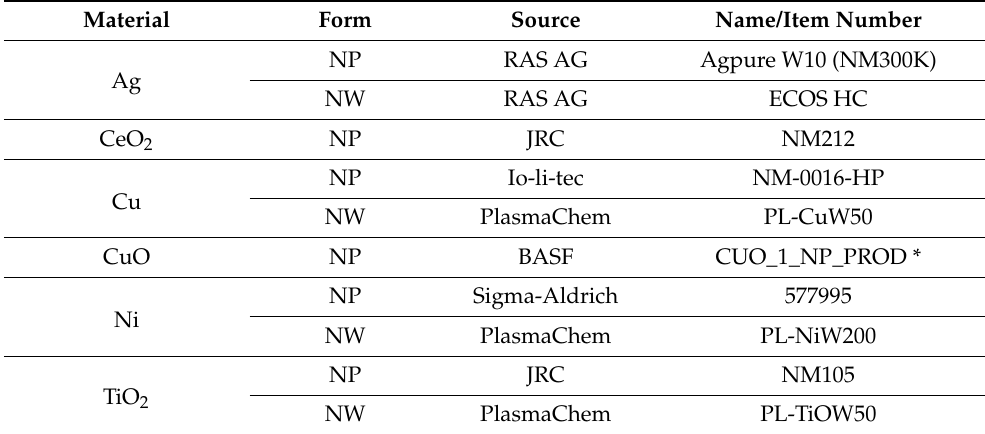
Table 1. Sources of all nanomaterials included in this